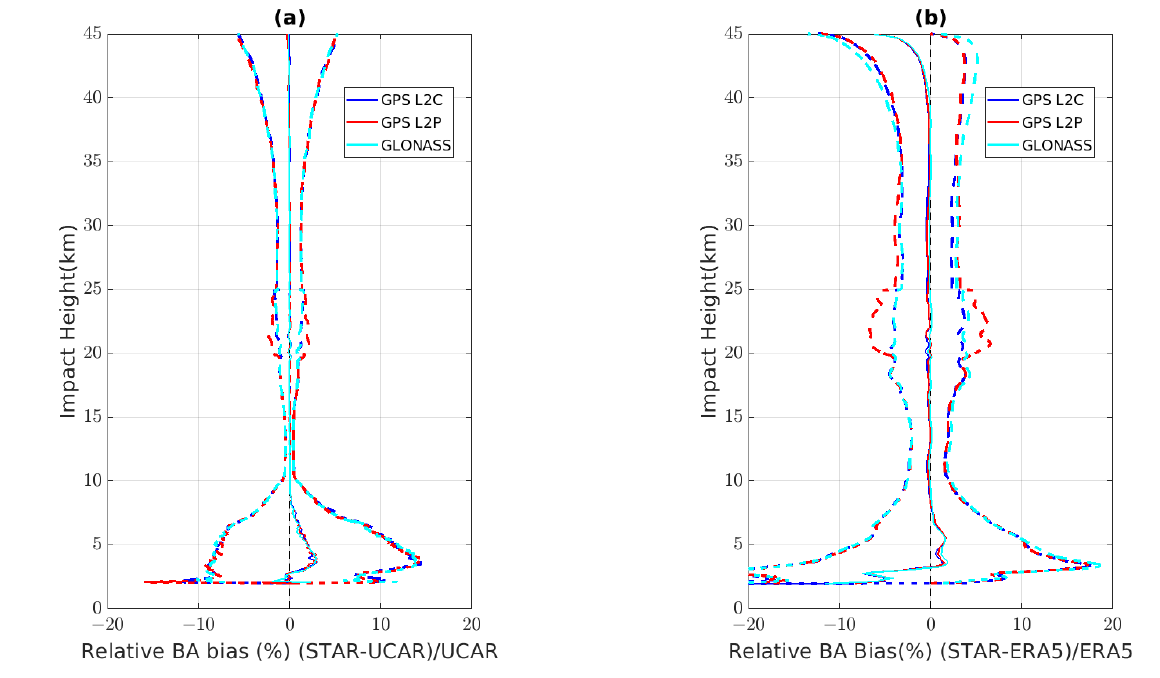
Figure 6. ( a ) Relative bending angle profiles compared with UCAR results and ( b ) ERA5 simulated results over October 2019. The profile is grouped as GLONASS L2C (cyan), GPS L2C/L2L (blue), and GPS L2P (red). The solid line represents the relative difference, and the dashed line is the standard deviation. The waggling structure compared with ERA5 is due to the forward operator from refractivity to bending angle calculation using Abel inversion.